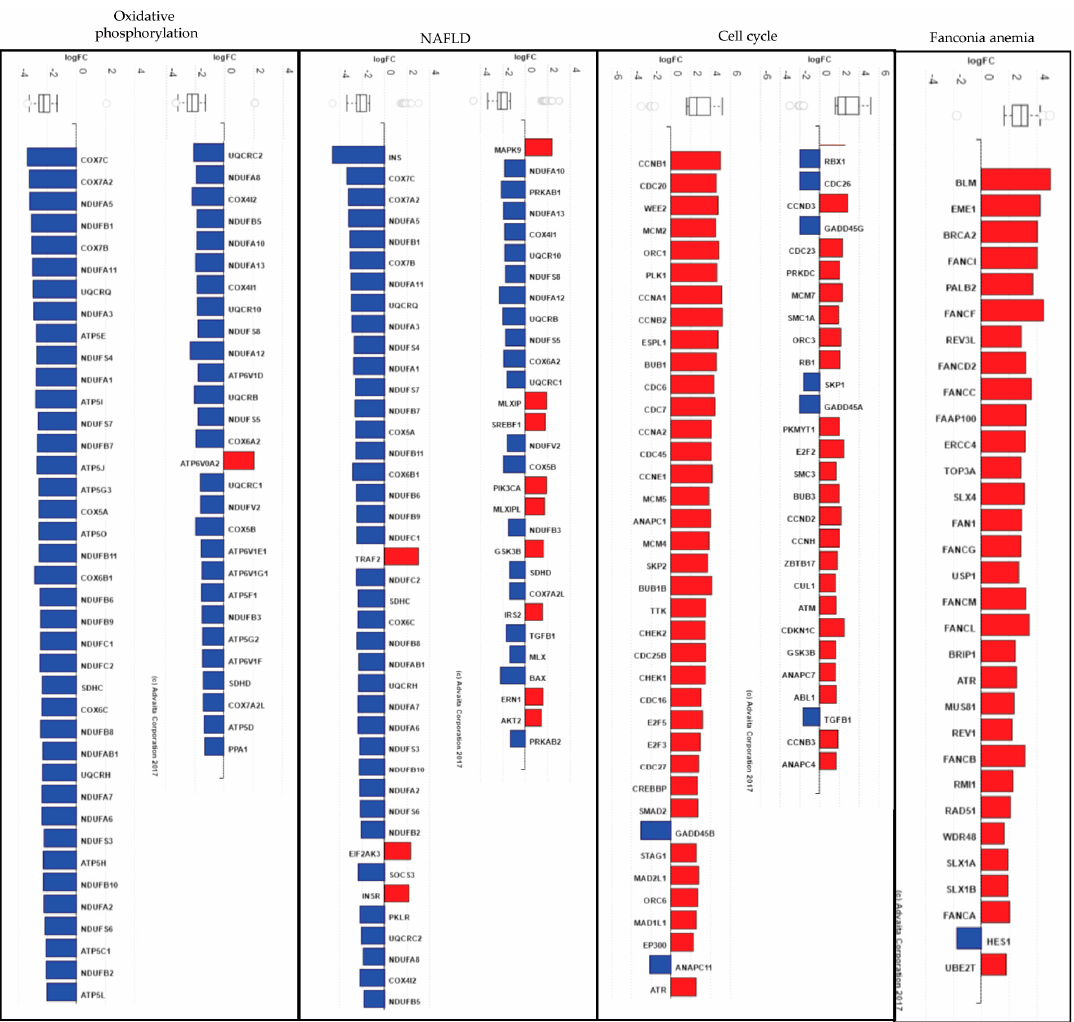
Figure 6. Advaita ‐ iPathwayGuide bar plots. All the genes in Oxidative phosphorylation (KEGG: 00190), NAFLD (KEGG: 04932), Cell cycle (KEGG: 04110) and Fanconia anemia (KEGG: 03460) are ranked based on their log 2 fold change (FC). For each gene, the FC is represented with negative values in blue and positive values in red. The box and whisker plot at the top summarizes the distribution of all gene expression for the specified pathway. The box represents the 1st quartile, the median and the 3rd quartile, while the outliers are represented by circles.